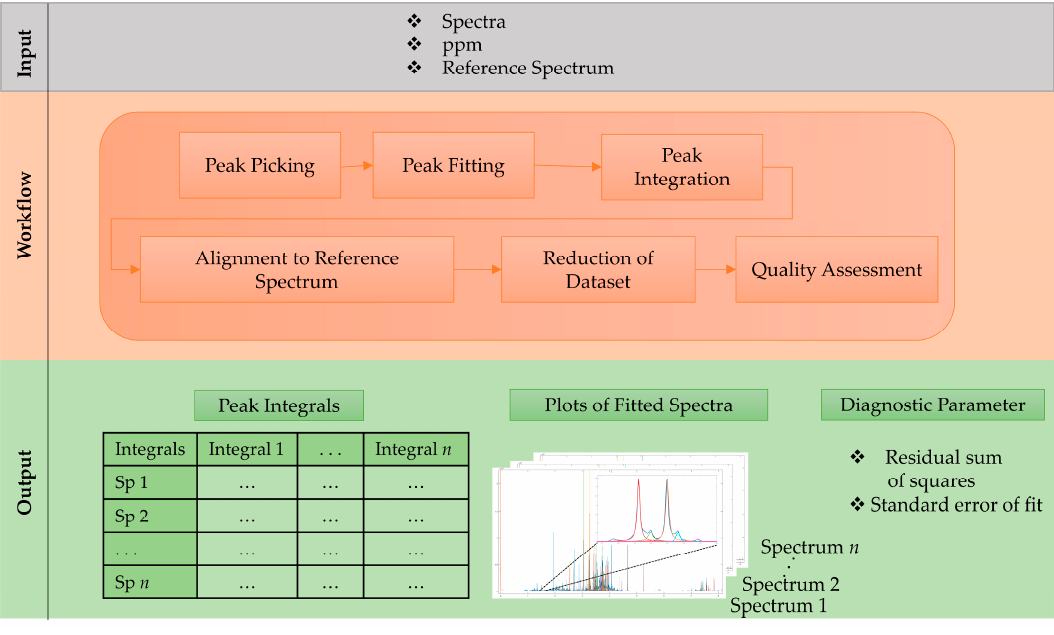
Figure 1. Step-by-step schematic workflow description for non-linear peak fitting based on Voigt line shape model .